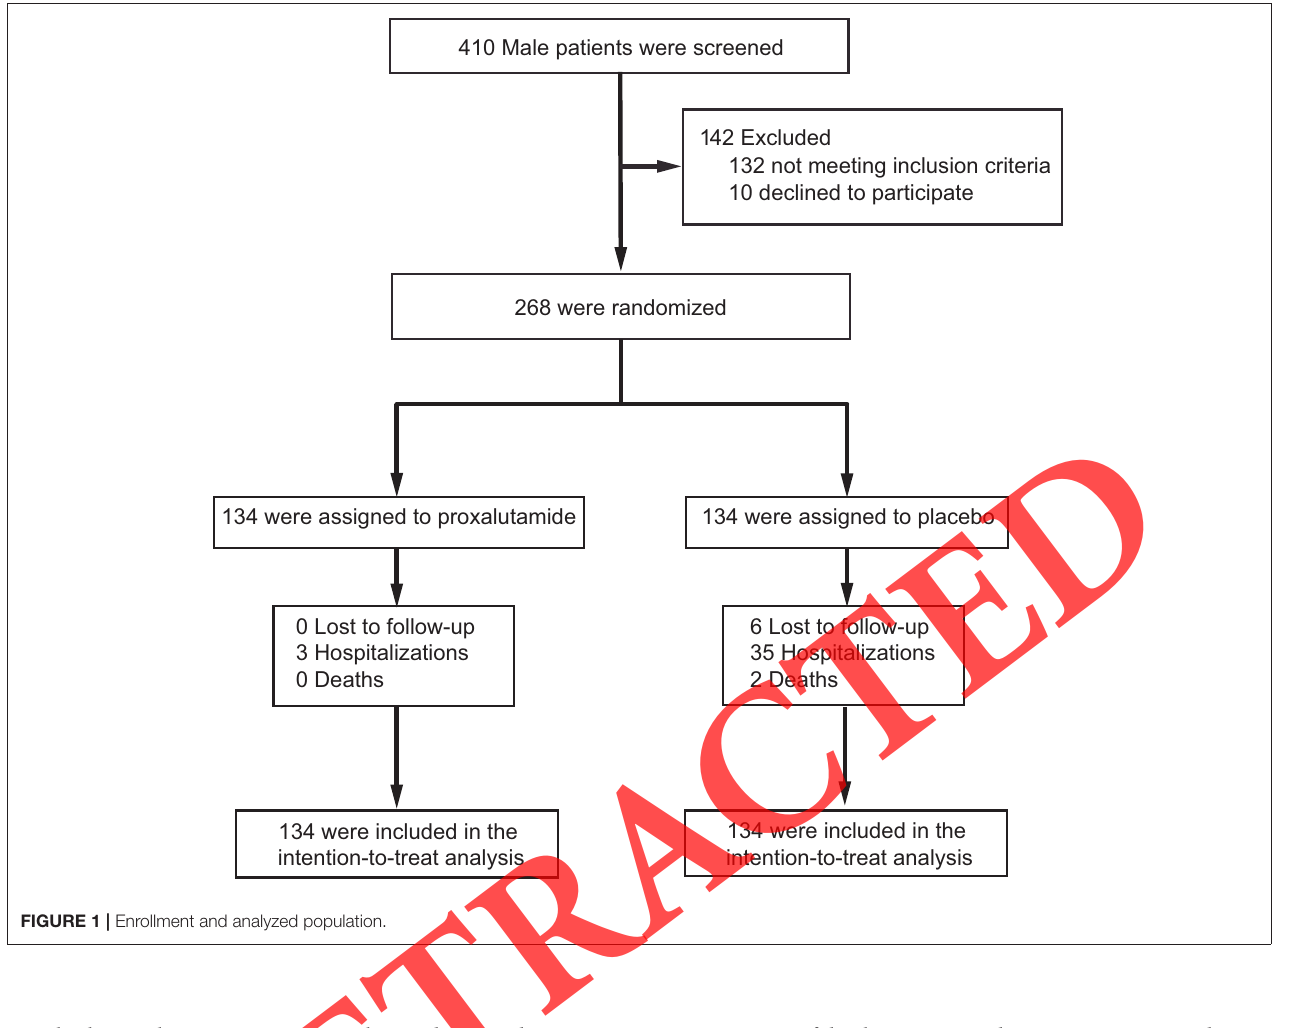
FIGURE 1 | Enrollment and analyzed